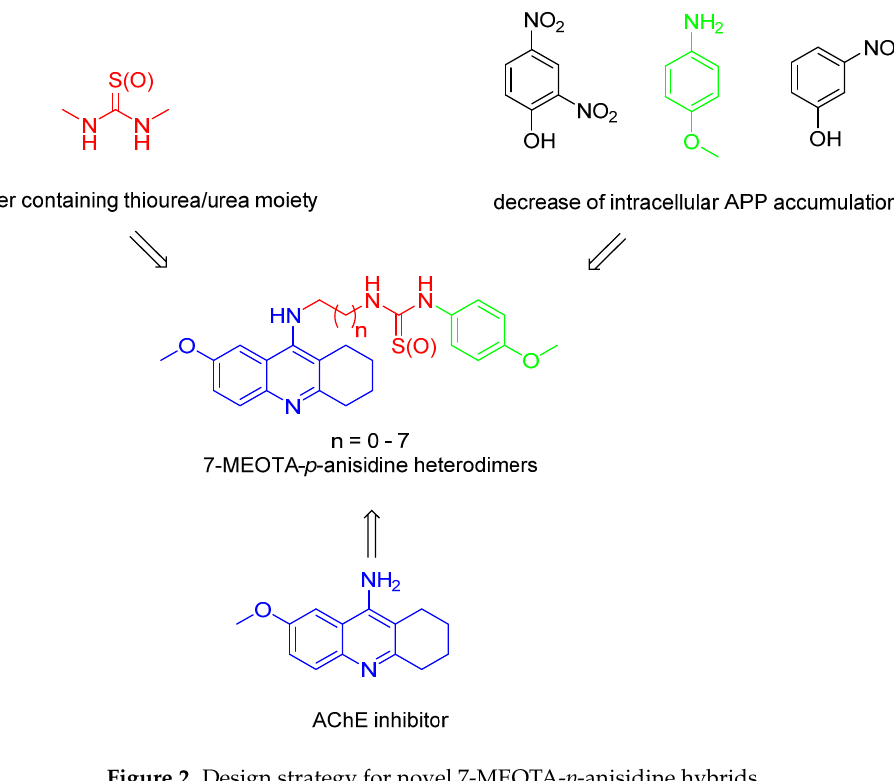
Figure 2. Design strategy for novel 7-MEOTA- p -anisidine hybrids.